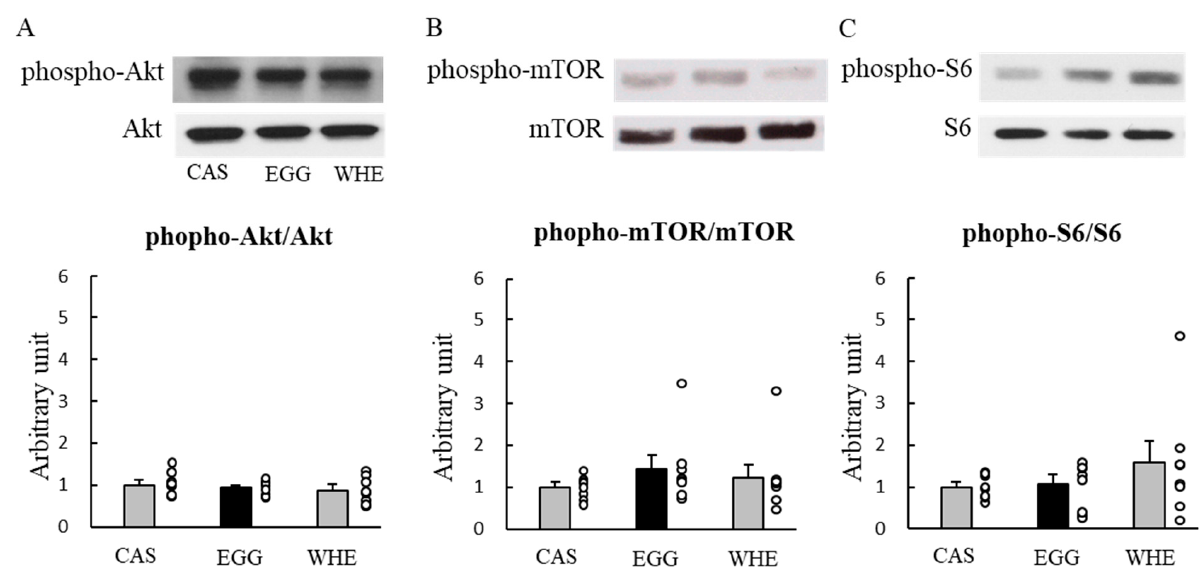
Figure 6. Chronic effect of each protein feeding on muscle signal transduction (Day 3). Rats were assigned to either a casein, egg white, or whey protein diet group, and were maintained under ad libitum feeding for 2 days without clenbuterol administration. On day 3, rats were fasted for 6 h, and then plantaris muscles were dissected out for western blot analysis of Akt ( A ), mTOR ( B ), or S6 ( C ). The dots beside bars indicate individual value. Values are means ± SE ( n = 8). CAS: casein protein, EGG: egg white protein, WHE: whey protein.